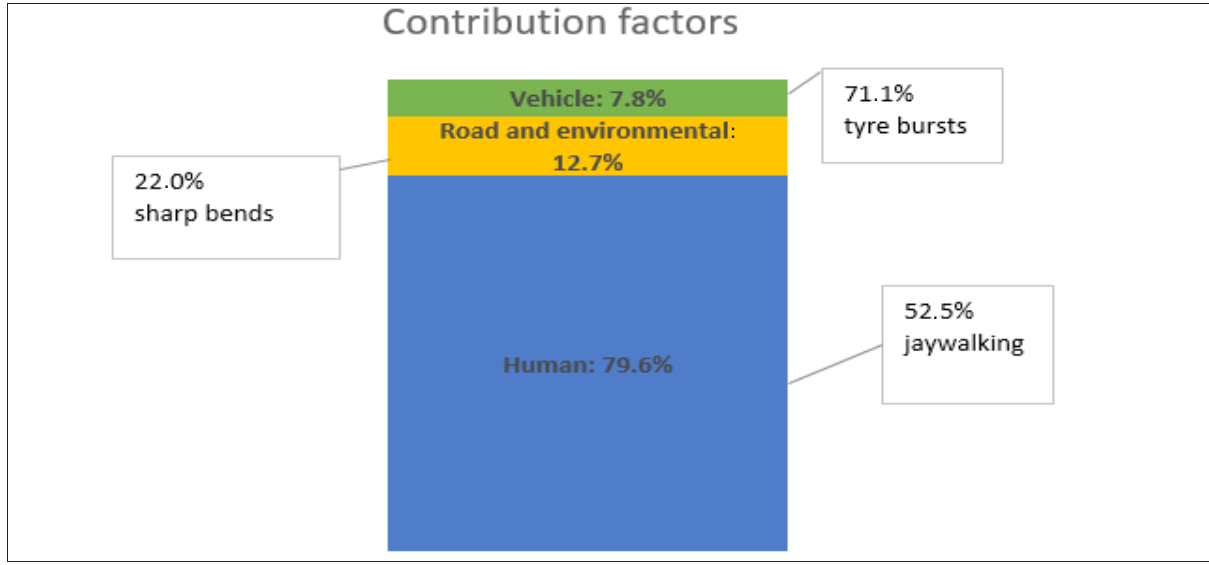
Figure 6: Graphical summary of the factors contributing towards fatal road